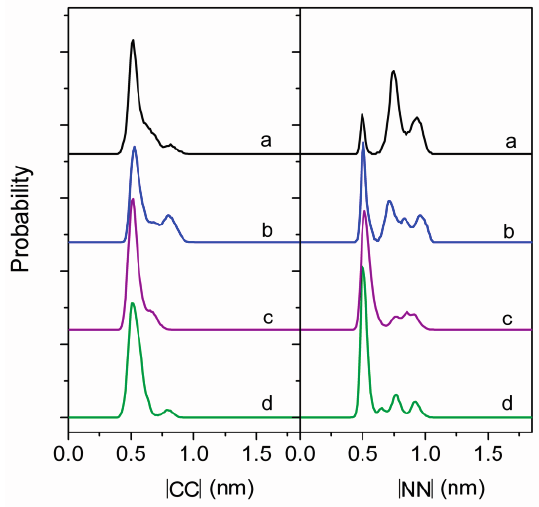
Figure 3. Snapshots of the representative arrangement of surfactin molecules at ( a ) 2.20 and ( b ) 1.20 nm 2 ·molecule − 1 (The atom coloring scheme is C, green; N, blue; O, red; and H, white). Reprinted with permission from Gang et al. [38]. Copyright (2011) American Chemical Society.